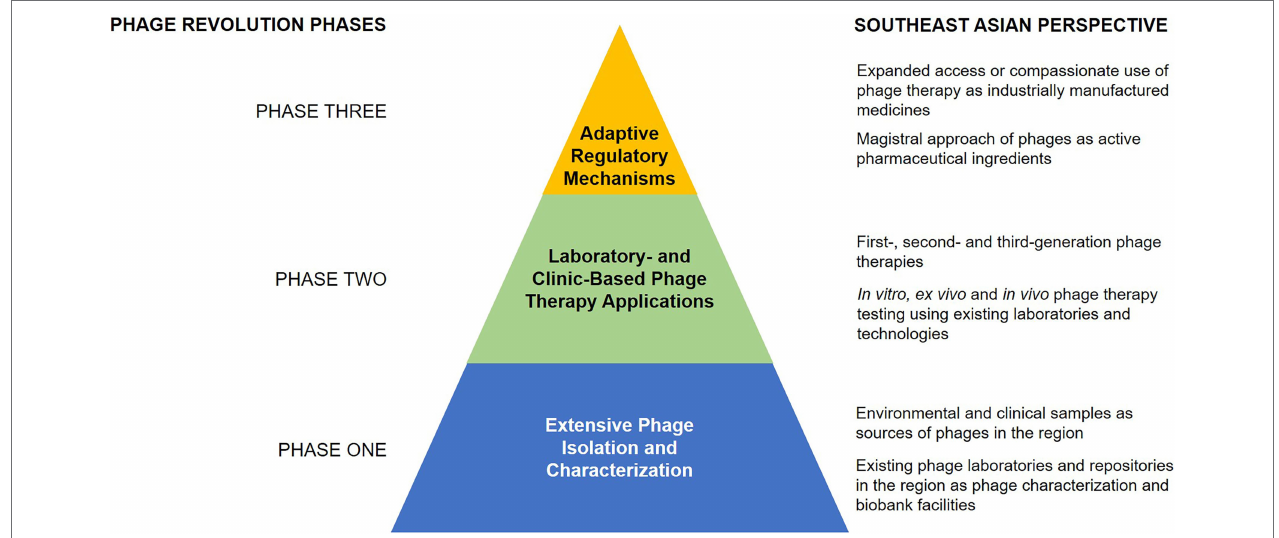
FIGURE 2 | A three-phase strategy for implementing a phage revolution, with perspectives for